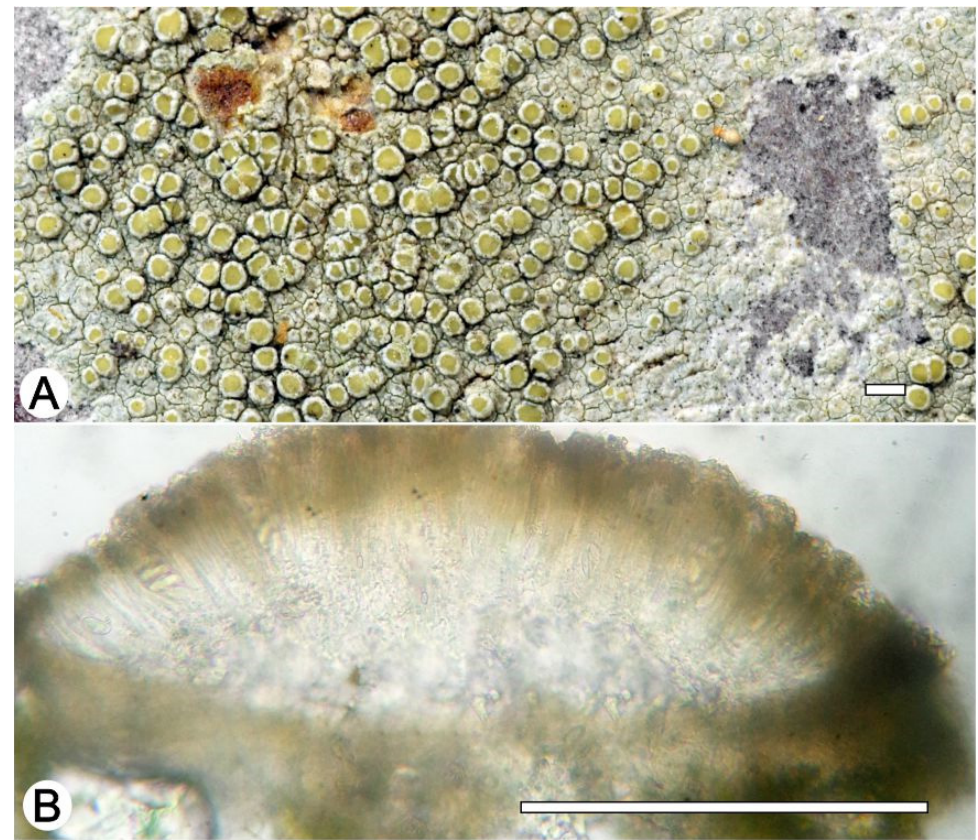
Figure 9. Lecanora notatictria sp. nov. ( A ) Thallus with ascomata (holotype ISE-46529); ( B ) Apothecial section in water (holotype ISE-46529). Scale bars: ( A ), 1 mm; ( B ), 100 µm.